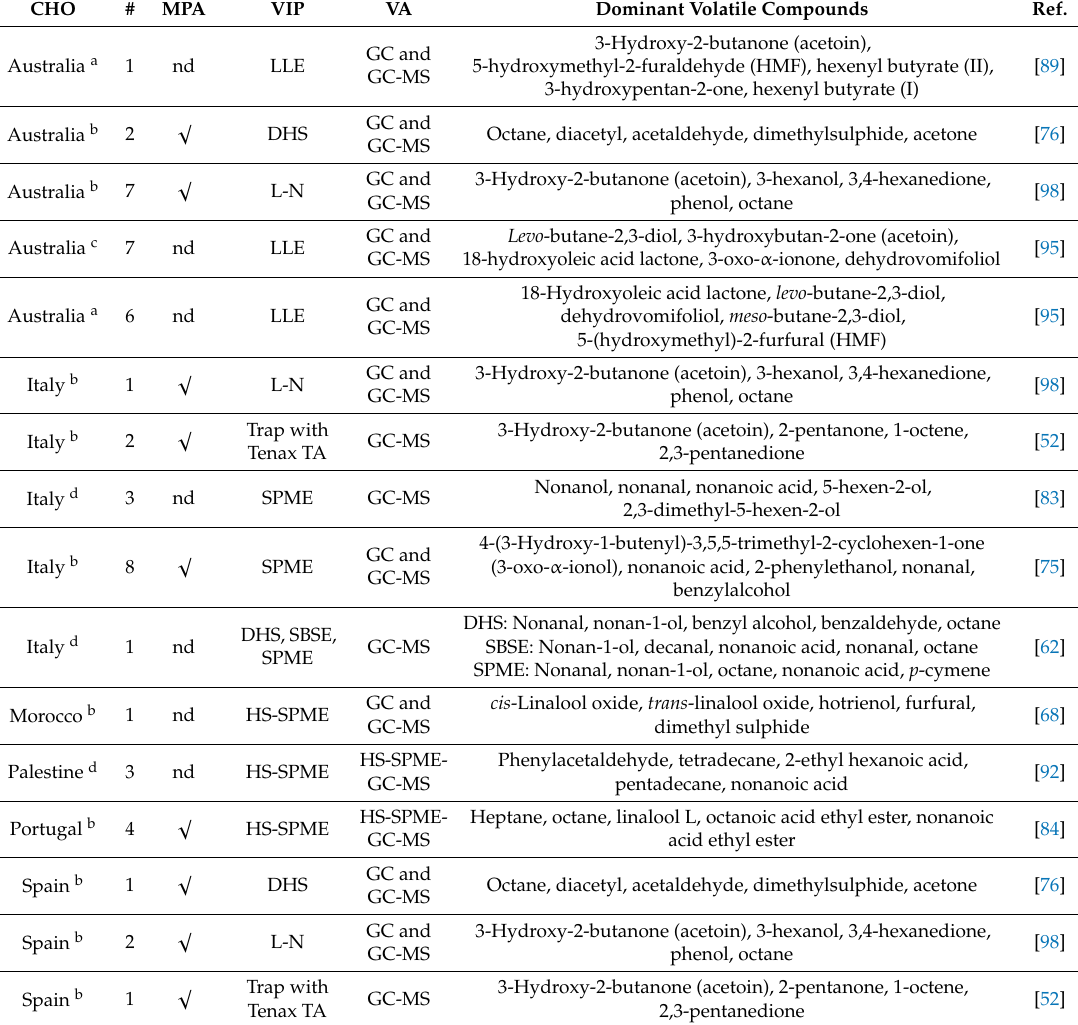
Table 8. Eucalyptus honey’s main volatiles, with reference to the country of origin, number of samples, isolation and analysis procedures and five main volatile components. Unless otherwise specified, the honeybee type was A. mellifera